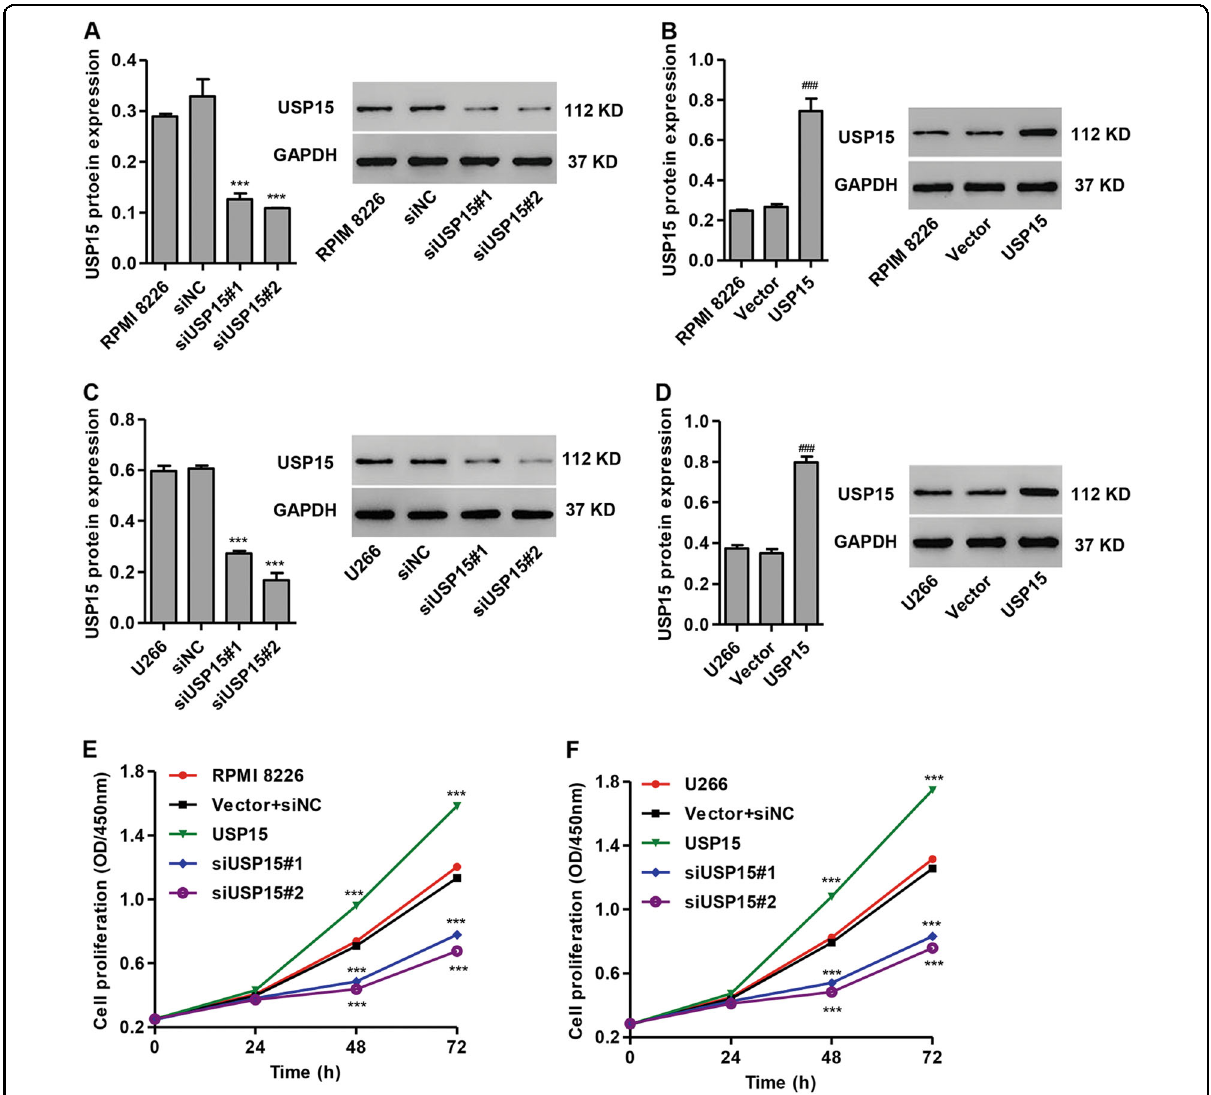
Fig. 2 Effects of USP15 RNA-interference and USP15 overexpression on MM cell proliferation. After RPMI 8226 and U266 cells were transfected with siNC plus empty pLVX-Puro (vector), siUSP15#1, siUSP15#2, or pLVX-Puro-USP15, the expression of USP15 was measured by western blot ( a – d ) and cell proliferation was measured by the CCK-8 assay ( e , f ). *** P < 0.001 compared with siNC, vector or vector +